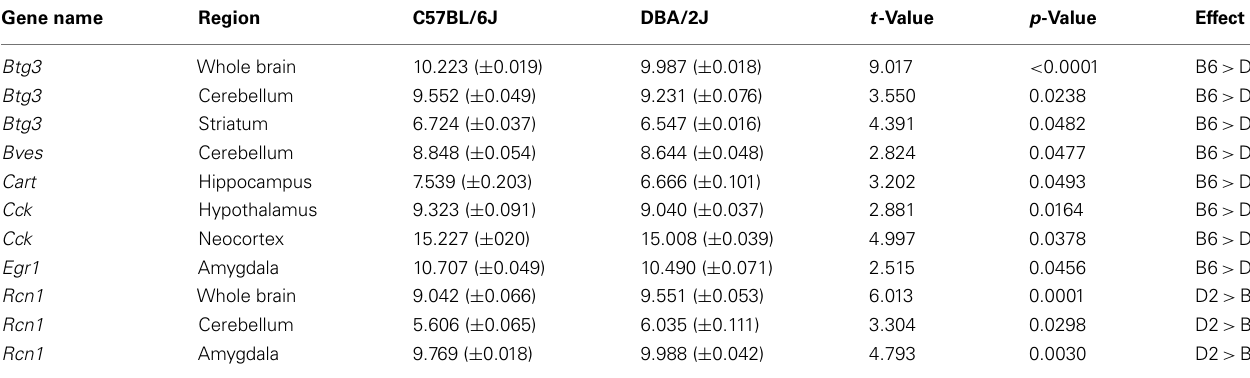
Table 4 | Confirmation of qPCR array results by in silico analyses of whole brain and brain region-specific microarray data.